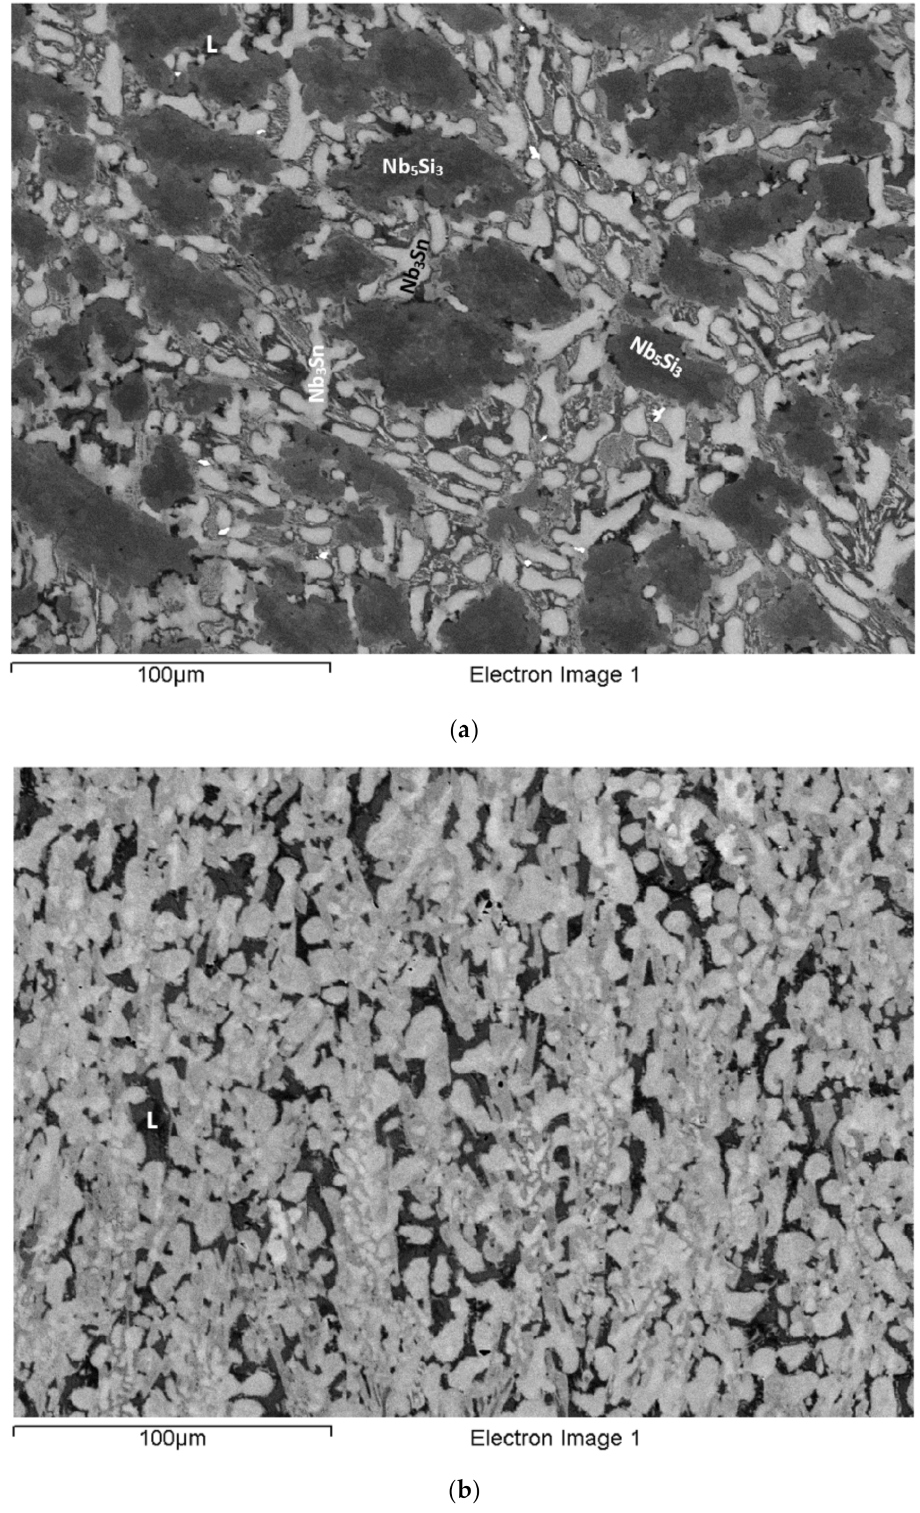
Figure 9. BSE images ( a ) of the bulk and ( b ) of the bottom of the as cast ingot of EZ8. Laves phase is indicated with